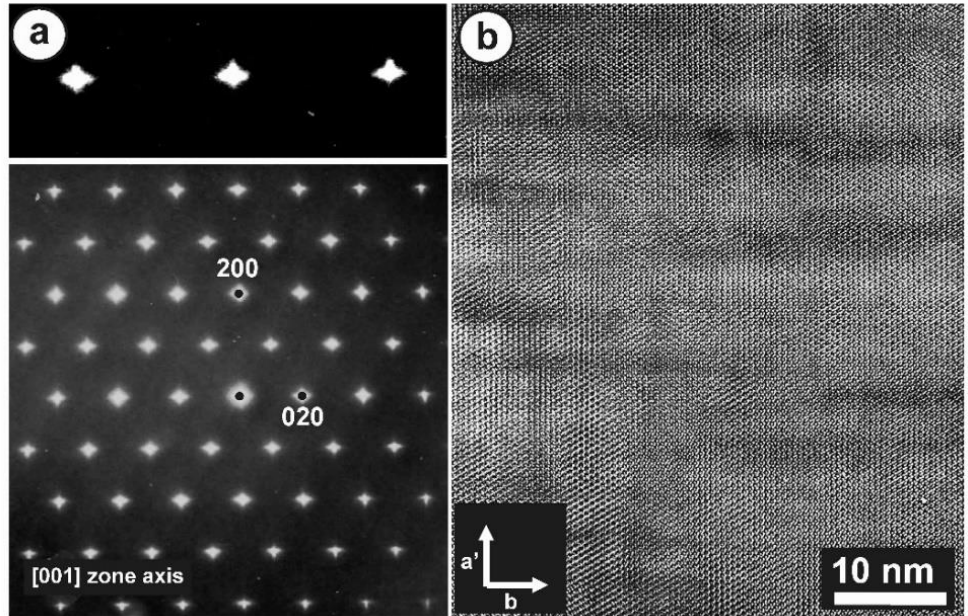
Figure 12. ( a ) An SAED pattern and ( b ) a TEM image at high resolution along the [001] zone axis of orthoclase specimen ASGS, show diffuse streaks instead of diffraction spots and the tweed modulation with a low amplitude. The electron-diffraction patterns and the electron-microscopy images were obtained with a JEOL 4000EX instrument at 400 kV [77].